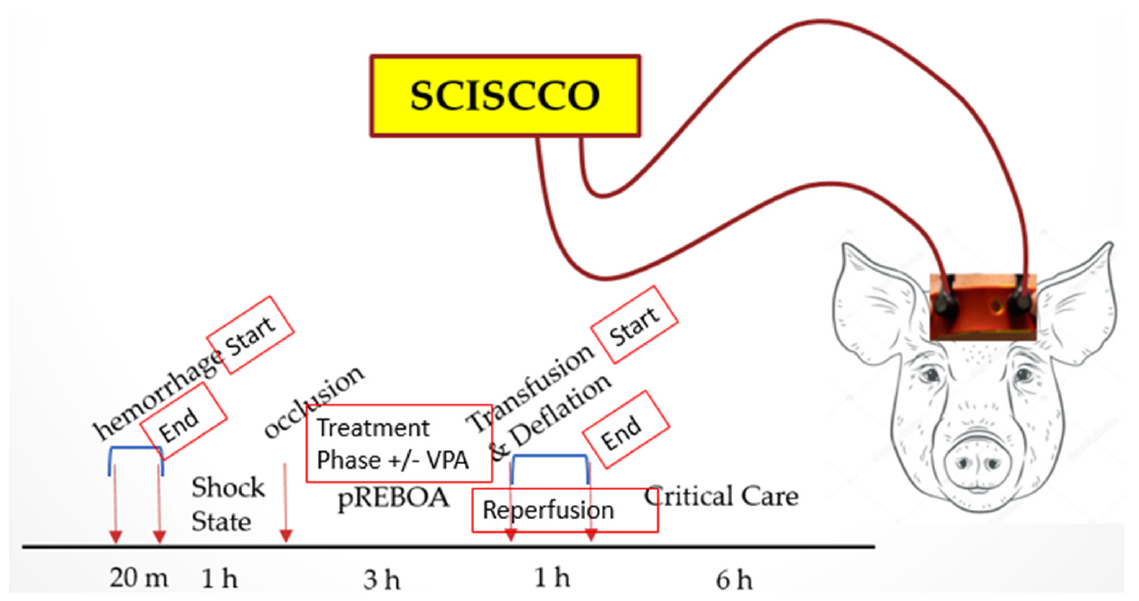
Figure 32. Animal study design (timeline) and SC probes secured on forehead of swine.